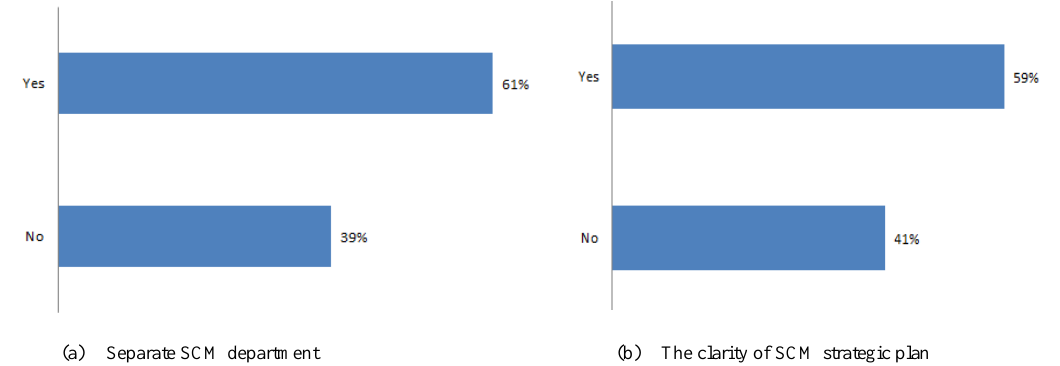
Figure 2. SCM in companies’ structure and